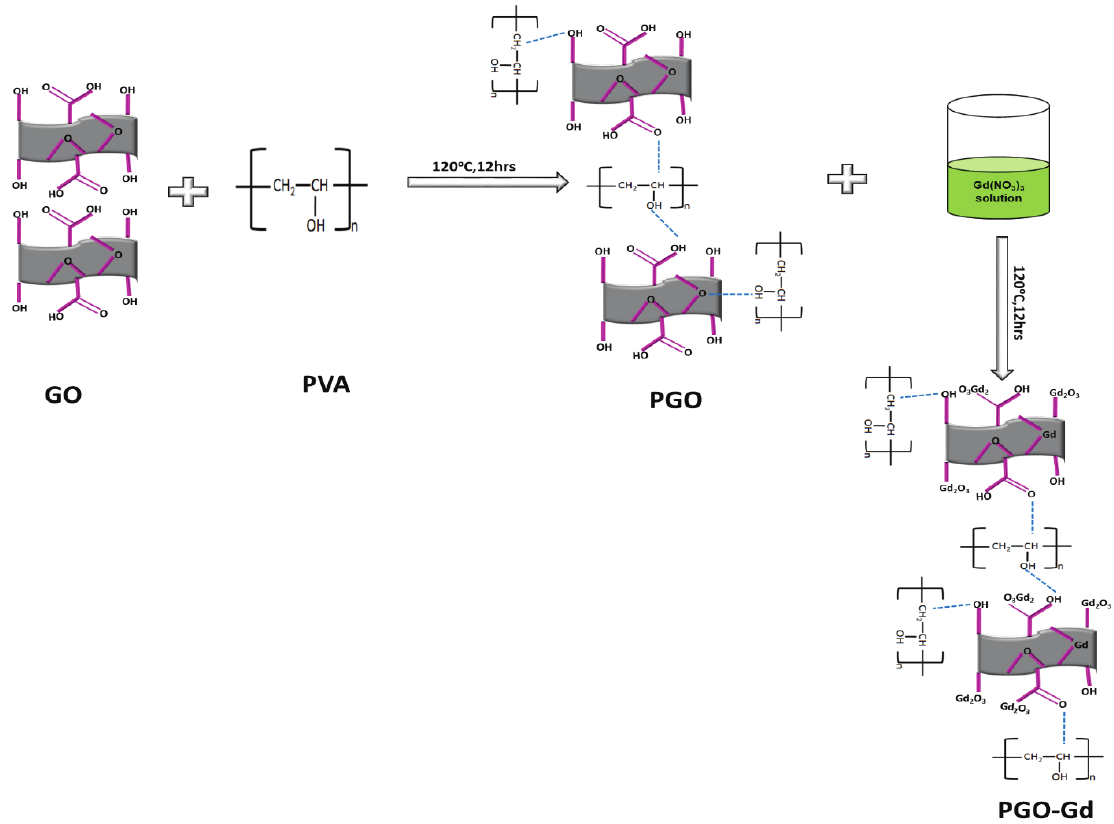
Figure 1. Schematic illustration of the method producing PGO–Gd.